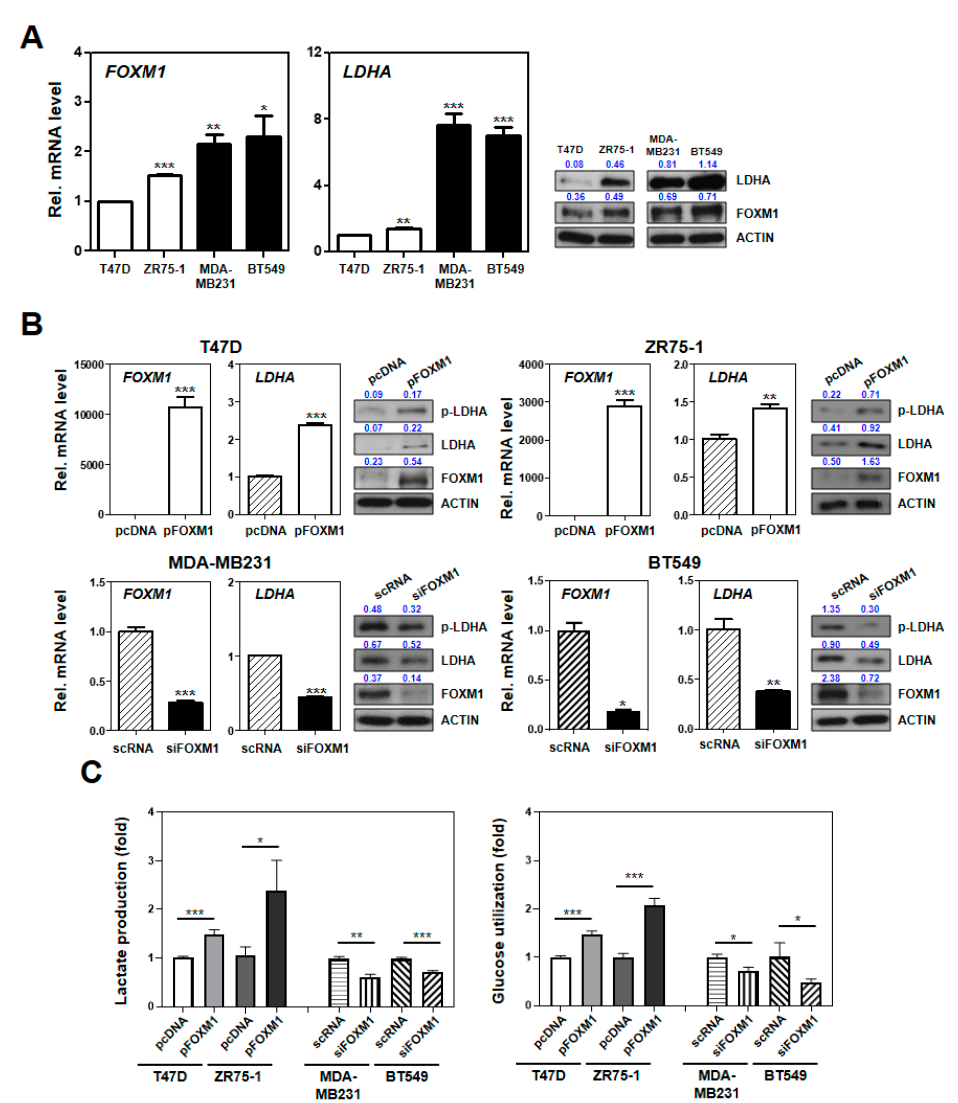
Figure 4. FOXM1 regulates LDHA expression, glucose utilization, and lactate production in breast cancer (BRC) cells. ( A ) Comparison between the expression levels of FOXM1 and LDHA in cancer cells defined as SUV-high cluster (SHC; MDA-MB231 and BT549) and SUV-low cluster (SLC; T47D and ZR75-1). The left two panels show the mRNA levels of FOXM1 and LDHA as determined by quantitative polymerase chain reaction (qPCR), and the right two panels show the protein expression levels of these two genes as determined by Western blotting. ( B ) In the upper panels, the SLC cell lines (T47D and ZR75-1) were transfected with pcDNA (control) or the FOXM1 overexpression vector (pFOXM1). In the bottom panels, the SHC cell lines (MDA-MB231 and BT549) were transfected with scrambled RNA (scRNA) or siFOXM1. The mRNA levels of FOXM1 and LDHA were measured by quantitative reverse transcription (qRT)-PCR. ( C ) The SLC and SHC cells were cultured for 24 h. A lactate assay kit was used for LDH production analysis, and a colorimetric glucose assay kit was used for glucose utilization confirmation. The absorbance was measured at 330 mm. Each bar represents the mean ± standard deviation of three independent experiments; p -values were obtained by two-sample t -tests. * p < 0.05; ** p < 0.01; *** p <